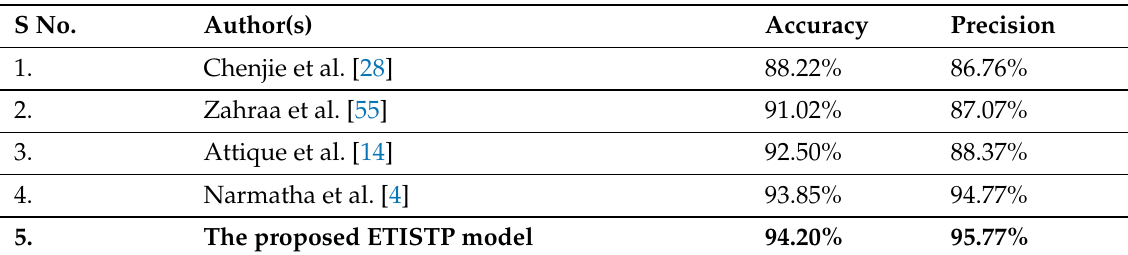
Table 12. Classification of a brain tumor with respect to LGG and HGG.